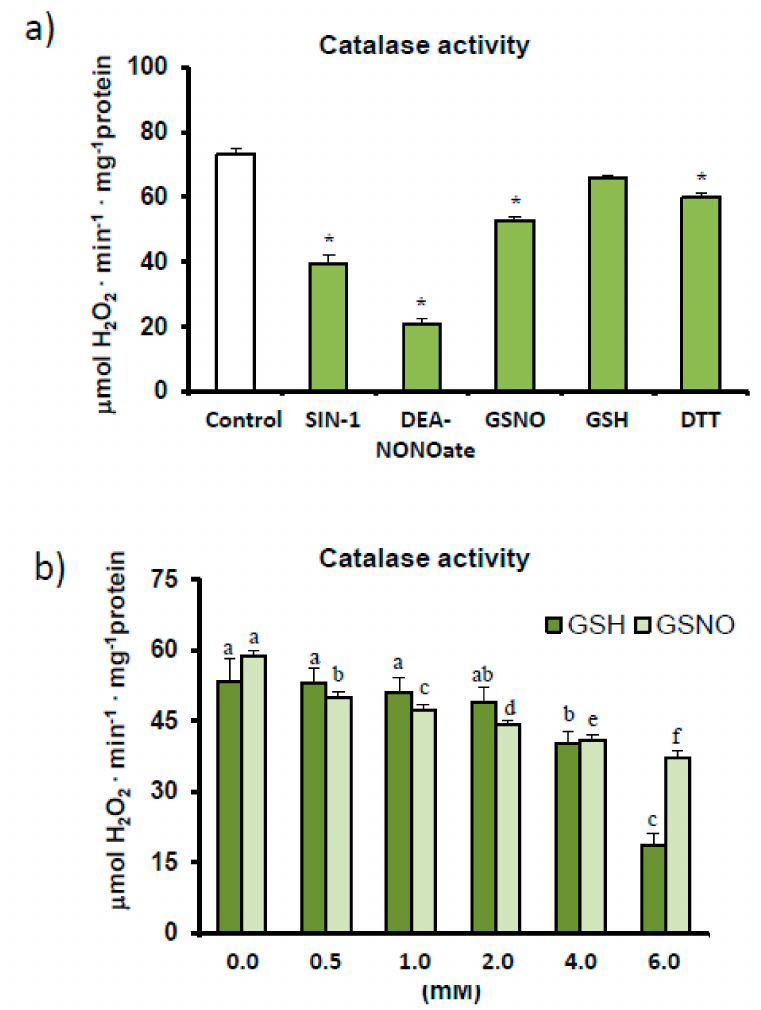
Figure 3. E ff ect of di ff erent modulating agents (ONOO − , NO, and reducing agents) on catalase activity in sweet pepper fruits. ( a ) Pepper samples were incubated for 45 min in the absence / presence of 2 mM 3-morpholinosydnonimine (SIN-1), 2 mM S -nitrosoglutathione (GSNO), 2 mM diethylamine NONOate (DEA-NONOate), 2 mM reduced glutathione (GSH), and 5 mM dithiotreitol (DTT), and catalase activity was then determined. Asterisks (*) denote significant di ff erences in treatments with respect to control conditions in the absence of agents (student t -test, p < 0.05). ( b ) E ff ect of reduced glutathione and nitrosoglutathione on catalase activity in green fruits. Crude extracts were incubated with di ff erent concentrations of GSNO and GSH (0–6 mM) for 45 min (25 ◦ C, darkness). Catalase activity was then determined spectrophotometrically. Results are means ± SEM of samples from at least three di ff erent experiments. Columns with di ff erent letters above each agent, either GSH or GSNO, di ff ered statistically (ANOVA, p <